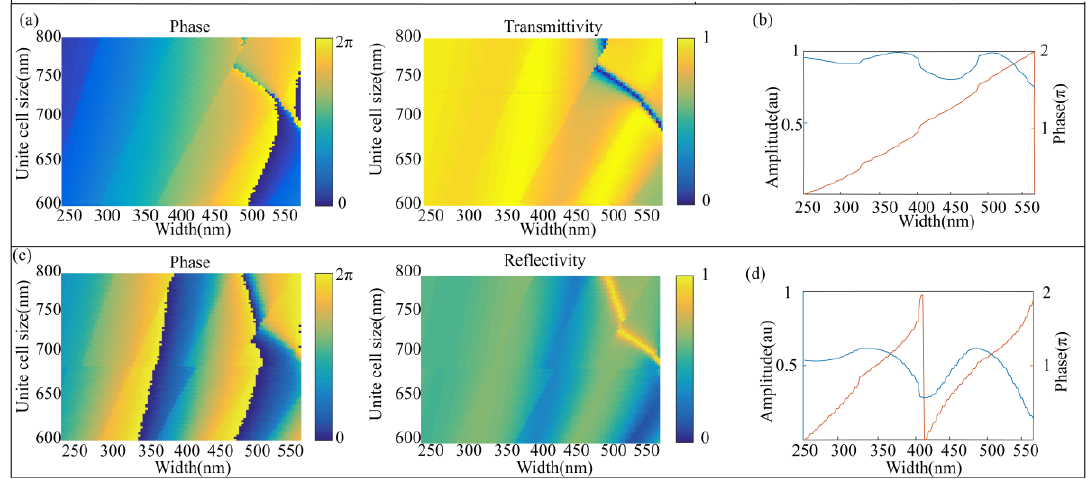
Figure 4. ( a ) Simulated transmittivity and phase of the transmitted field as a function of the unit cell size and the width of SSN nanopillar when VO 2 is in the insulator phase. ( b ) Simulated transmittivity and phase of the transmitted field for a fixed unite cell size of 652.5 nm. ( c ) Simulated reflectivity and phase of the reflected field as a function of the unite cell size and the width of SSN nanopillar when VO 2 is in the metallic phase. ( d ) Simulated reflectivity and phase of the reflected field for a fixed unite cell size of 652.5 nm. All the simulated results for ( a – d ) are performed at the wavelength 1550 nm with x-LPL incidence.